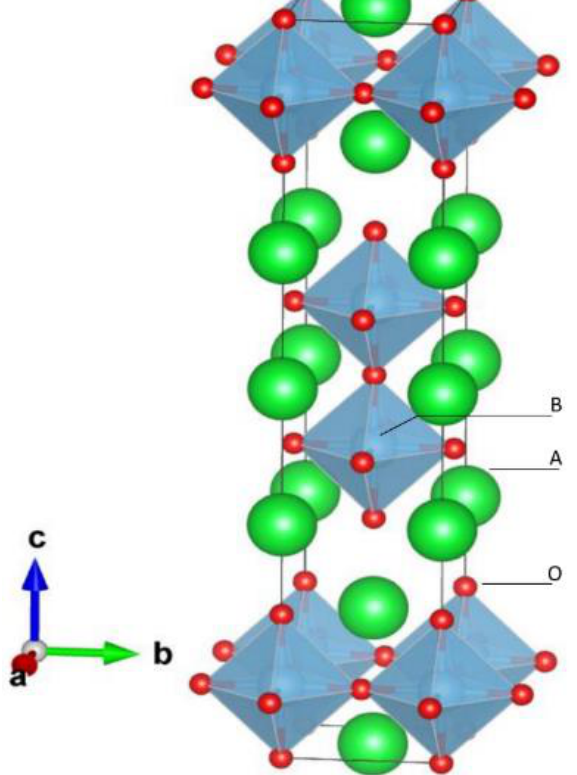
Figure 4. Another perovskite-related structure is the Ruddelsden Popper structure. The layered perovskite family contains several polar and ferroelectric materials in contrast to bulk ABO 3 perovskites. The (100)-oriented 2D perovskites are by far the most abundant class, and have been explored for a wide variety of cation templates. The geo- metrically planar inorganic–organic interface of the (100)-oriented layers not only allows the incorporation of a plethora of “spacer” cations between the 2D perovskites, but it also allows for the template “build-up” of the perovskite itself, which self-assembles in a layer-by-layer fashion between the spacers. These modular multilayered structures were first discovered in the oxide perovskites, where they were used to expand ex- tended homologous series [19,23]. Following the oxide perovskite nomenclature, the (100)-oriented oxide perovskites can be further categorized as the Ruddlesden Popper (RP) phases [24,25], the Dion Jacobson (DJ) phases [24,25], and the Aurivillius phases [26,27], as shown in Figure 5, [28] where their general formulae can be written as A (cid:48) 2 A n − 1 B n O 3n+1 , A (cid:48) A n − 1 B n O 3n+1 and (Bi 2 O 2 )(A n − 1 B n O 3n+1 ), respectively. In the case of halide perovskites, most of these structure types have been realized, with the exception of the Aurivillius phases. It is entirely possible, however, that such layers can be formed using less reactive rock-salt-type layers, such as (Ba 2 F 2 ) 2+ . As in the case of oxide perovskites, as well as in the case of halide perovskites, the nature of the spacer cation is important. Already, from the expression of the chemical formula, it is evident that the charge of the spacer cation defines the structural types of 2D perovskites. Nevertheless, both RP and DJ classes exist for the halide family, having the general formula of A (cid:48) 2 A n − 1 B n X 3n+1 and A (cid:48) A n − 1 B n X 3n+1 (A (cid:48) = interlayer “spacer”